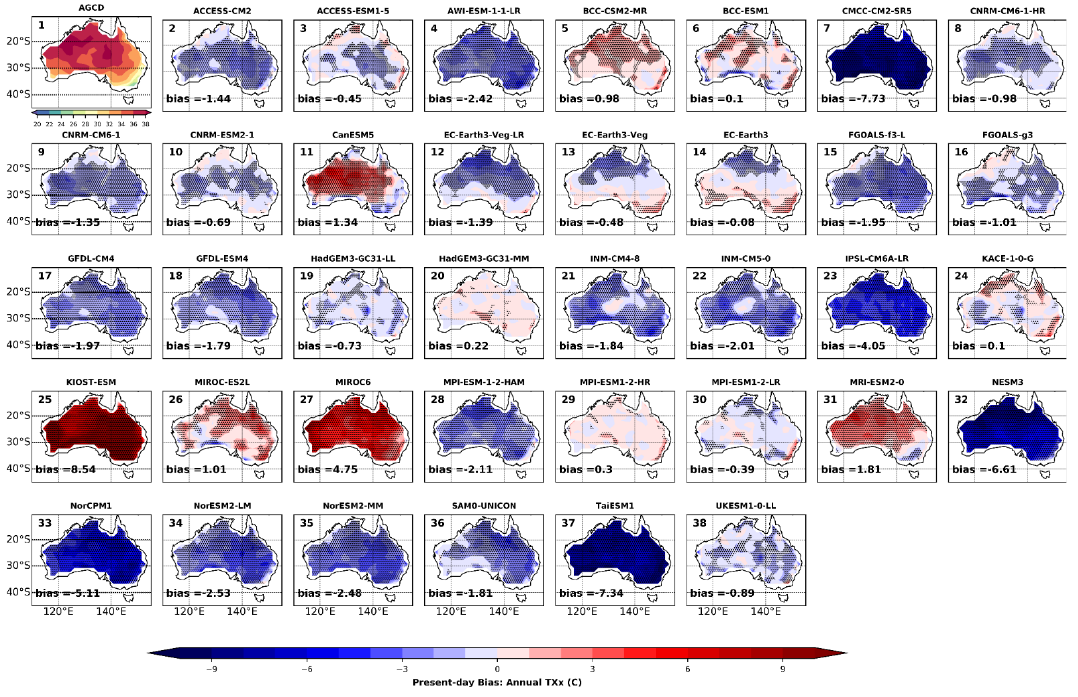
Figure 6. Climatological mean annual bias in maximum maximum temperature (TXx: °C) relative to the Australian Gridded Climate Data dataset (AGCD; panel 1 ) for the individual CMIP6 GCMs (panels 2 – 38 ). Data spans 1951–2014. Stippling indicates statistically significant differences using a student’s t-test at the 95% confidence level.